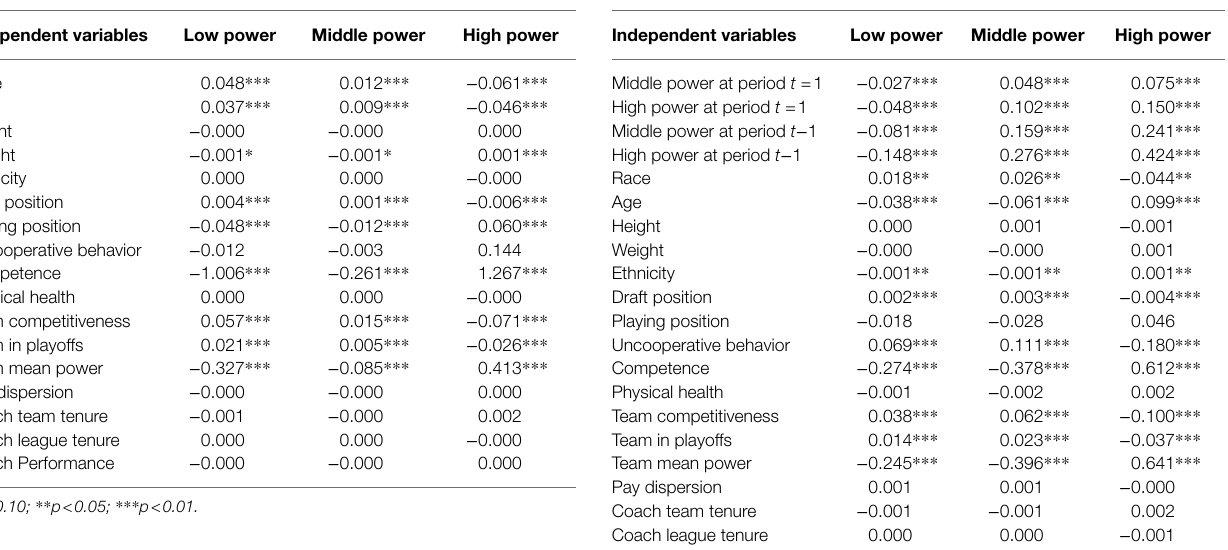
TABLE 6 | Marginal effects of the Wooldridge’s dynamic ordered probit model on the probability of power a .